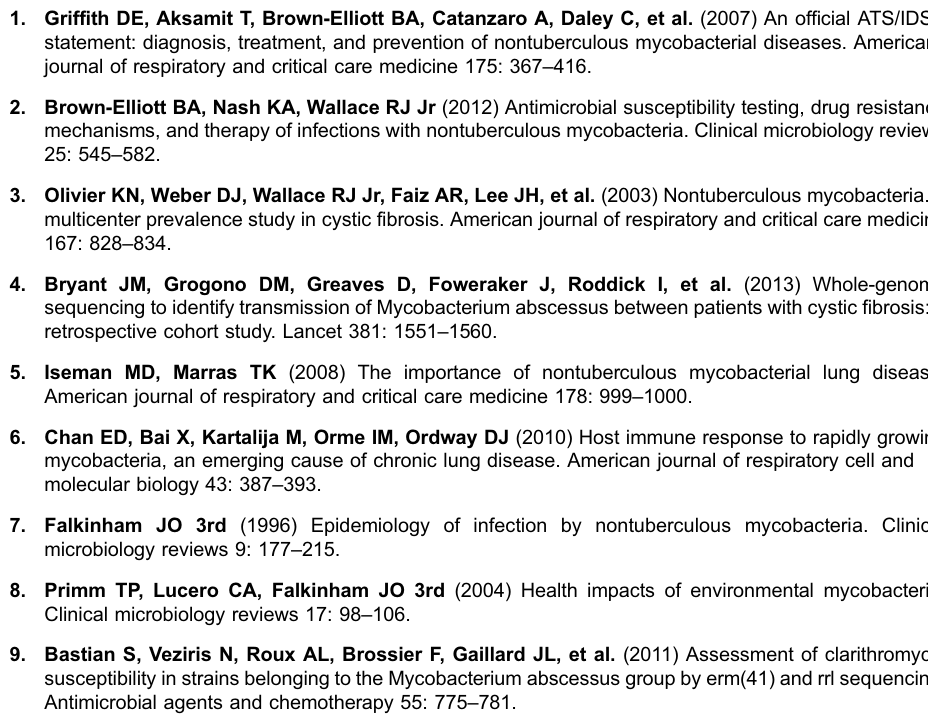
S2 Table. The unique gene loci in M. massiliense JCM15300. S3 Table. The deleted genes of massiliense and bolletii clusters among M. abscessus group. S4 Table. Oligonucleotide primer sequences used in PCR assays and the judging method for presence of MmGI-1 and other M. massiliense unique regions. S5 Table. Isolates analyzed in the present study and results of conventional PCR based detection against MmGI-1 and other M. massiliense unique